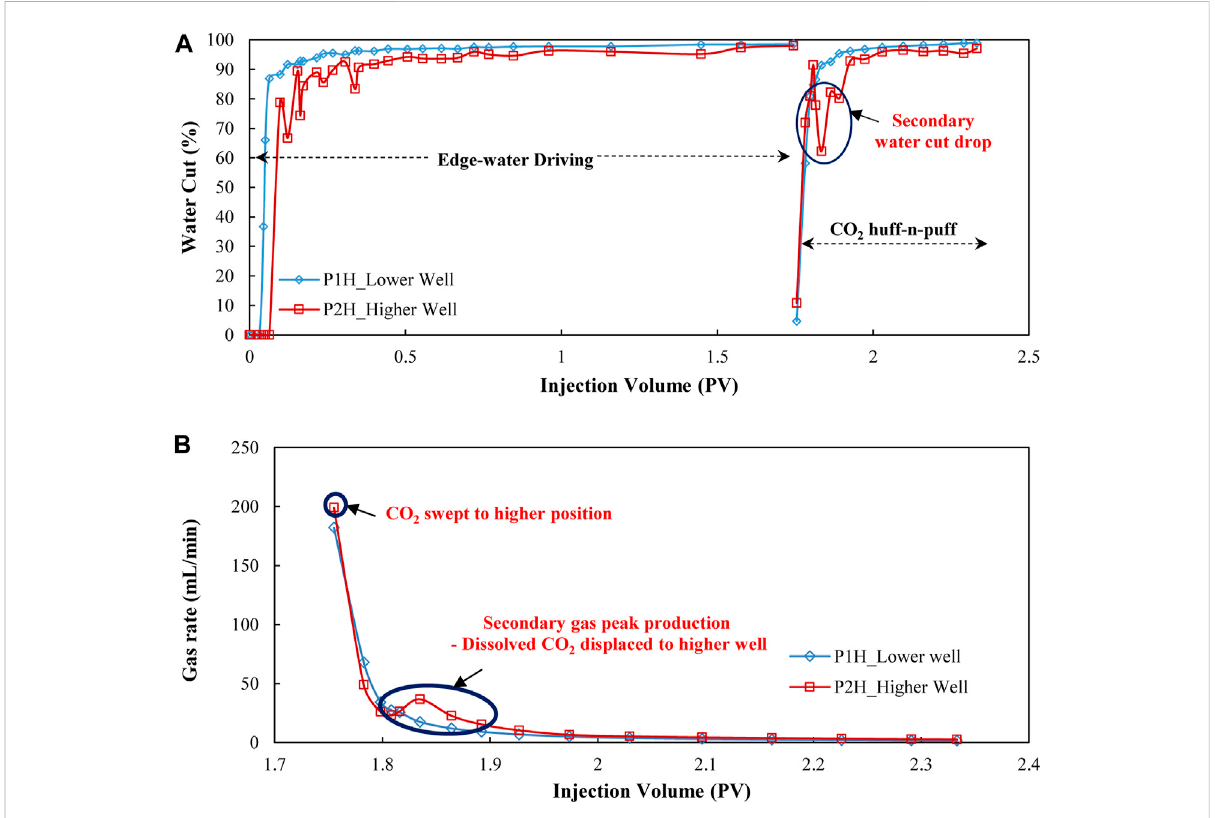
FIGURE 8 Production performance for single wells in Scenario 2 with CO 2 injected only through the lower well P2H. (A) Water cut curves. (B) Gas rate